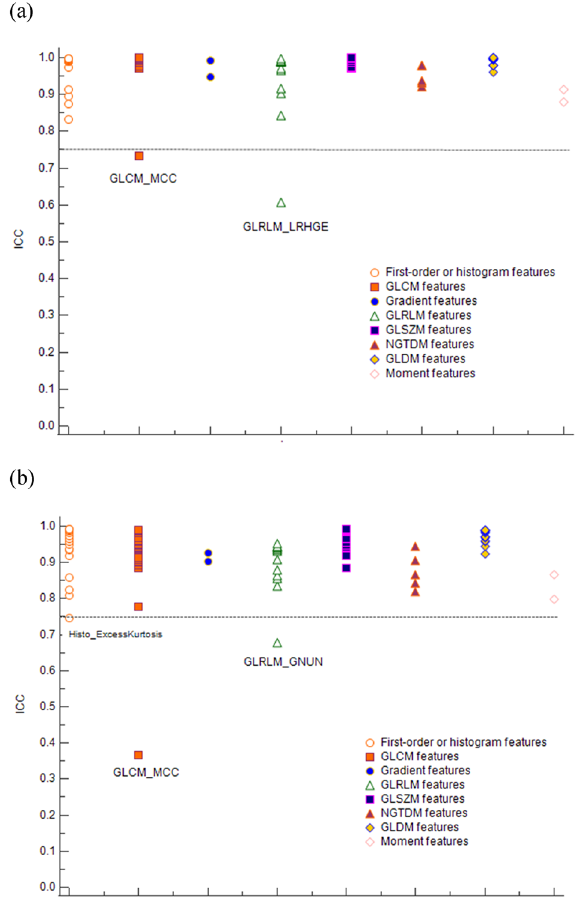
Figure 2. Distribution plot for intraclass correlation of radiomic features of ( a ) myocardium and ( b ) periprosthetic mass. Radiomic features are lined on the x axis and color coded based-on which family of radiomics features they belong to, while their corresponding intraclass correlation coefficient is plotted on the y